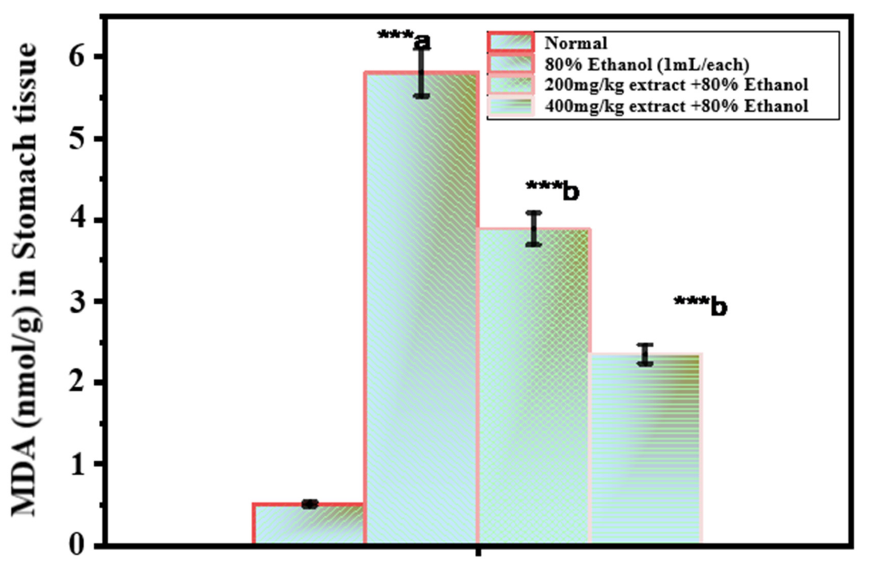
Figure 2. Effect of O. forsskalii extracts on the MDA concentration in gastric ulcer induced by 80% ethanol. Six rats were used in each group. p values (*** p < 0.001). Where, a: 80% ethanol treated group was statistically compared to the normal group; b: O. forsskalii treated groups were compared to the ethanol-treated group.